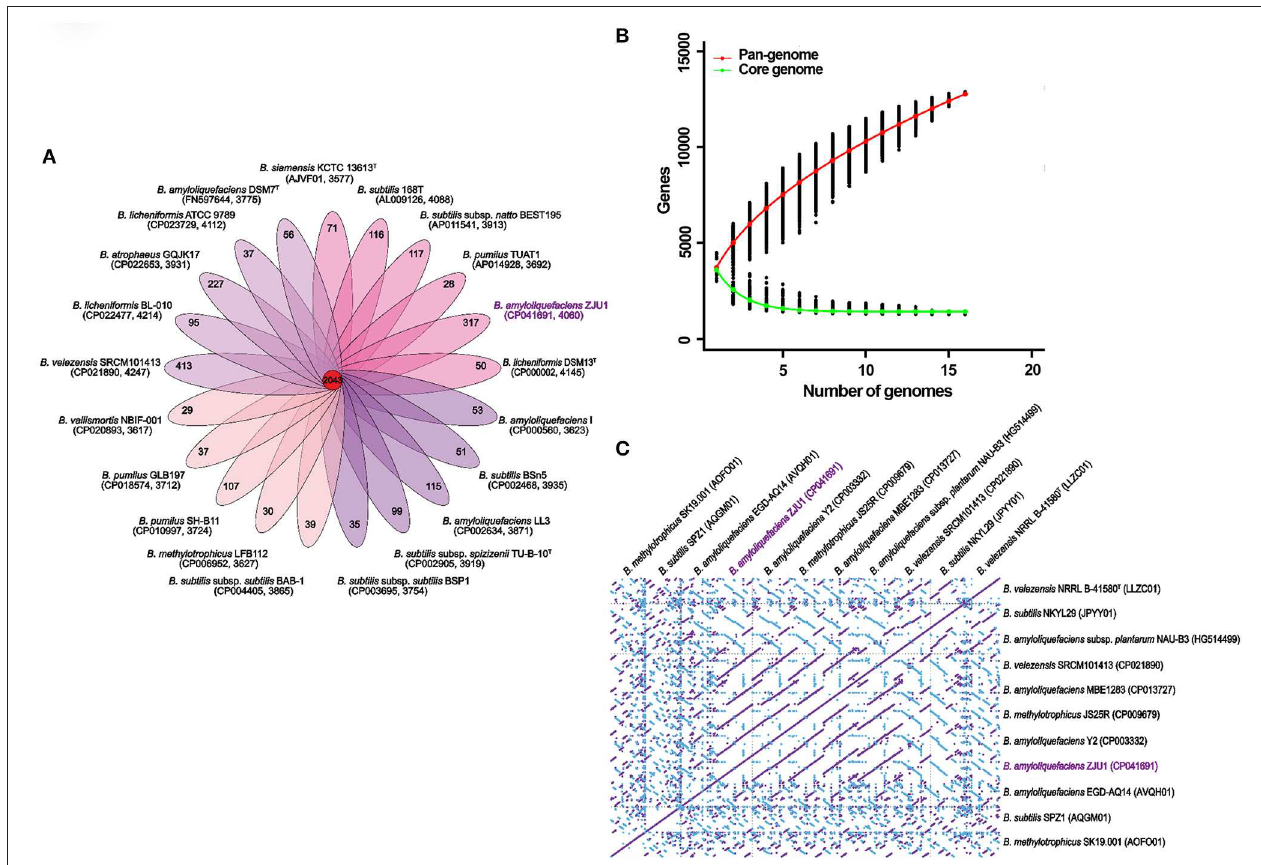
FIGURE 3 | Multigenomic analysis revealing the pangenome of Bacillus and genome synteny. (A) Flower plot illustrating the number of shared (core) and specific (accessory/dispensable) genes based on clusters of orthologs. Each petal displays the number of strain-specific genes found in each genome, with the core orthologous gene number in the center. Inside the brackets, the accession number of the strain and its total number of gene families are shown. (B) Pan and core genome gene numbers in representative Bacillus taxa. The red continuous curve represents the total number of genes (pangenome) for a given number of sequentially added genomes; green indicates the number of ubiquitous genes (core genome) as a function of the number of sequentially added genomes. The vertical bars correspond to standard deviations after repeating random combinations of the genomes. (C) Synteny plot of Bacillus chromosomes based on whole-genome alignments. The diagonal lines calculated with MUMmer display the homologous regions in pairwise genome comparisons. Forward and complimentary strands between the genomic sequences are represented in purple and blue,